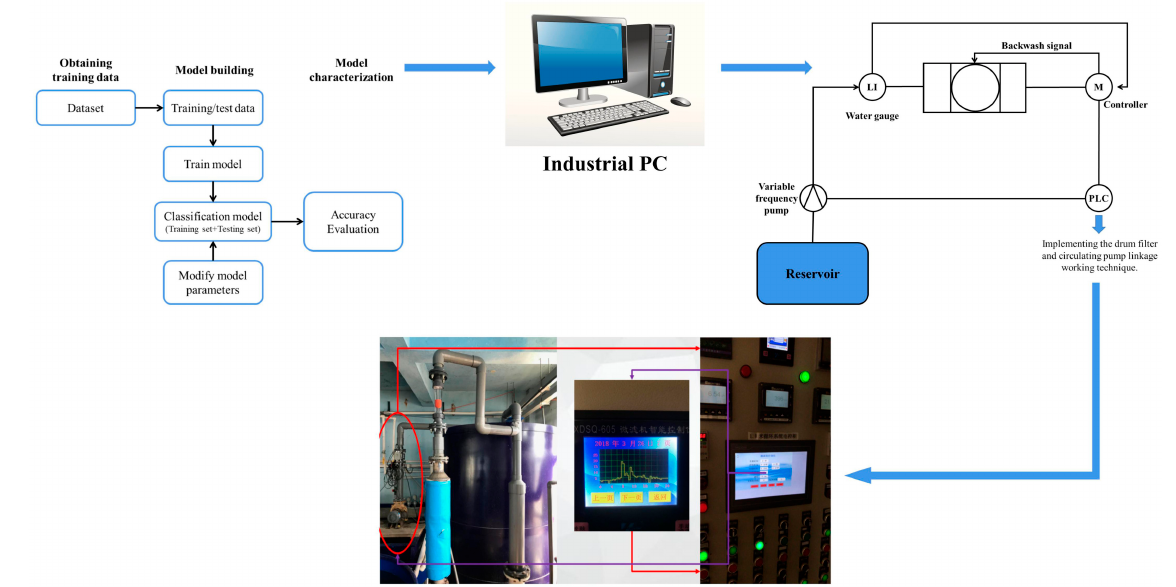
Figure 2. Design of control system in the variable-flow RAS.